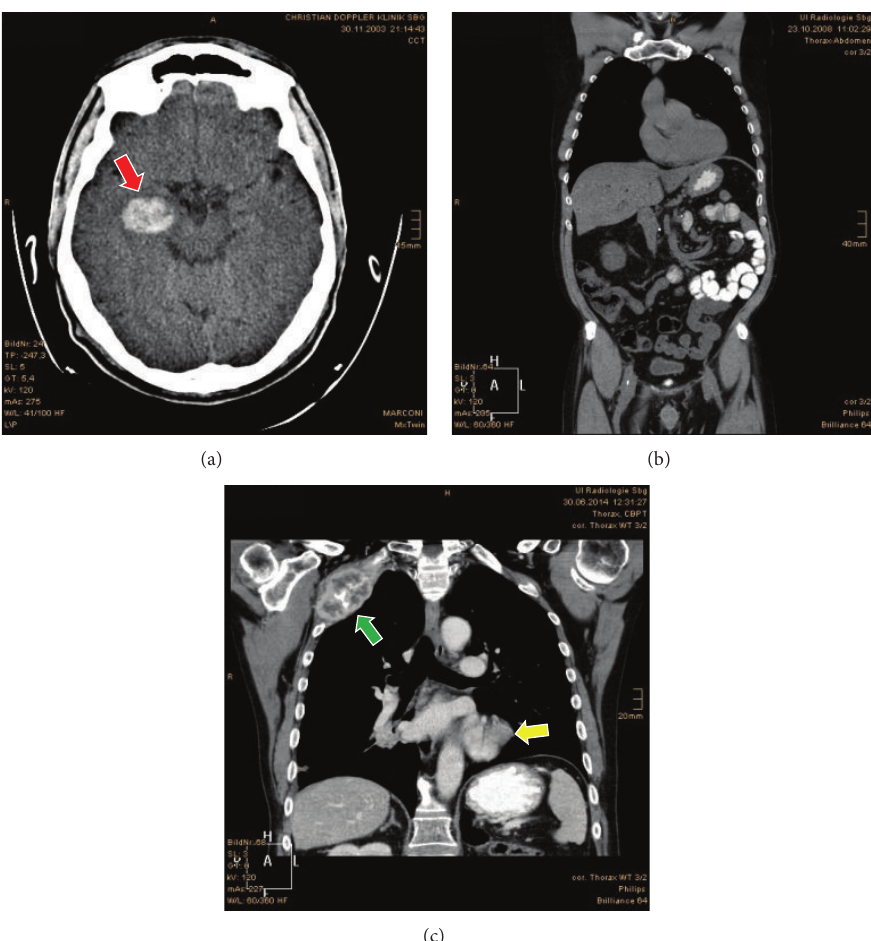
Figure 1: (a) Red arrow: brain CT axial view showing brain metastasis at the right temporal lobe in 2003. (b) Thorax, abdomen, and pelvis CT coronal view showing no evidence of metastasis after multiple metastasectomies. The scan was performed in 2008. (c) Recent (2014) chest CT coronal view showing a metastatic focus on the left lower lung lobe (yellow arrow) as well as an osteoclastic lesion involving the upper two ribs (green